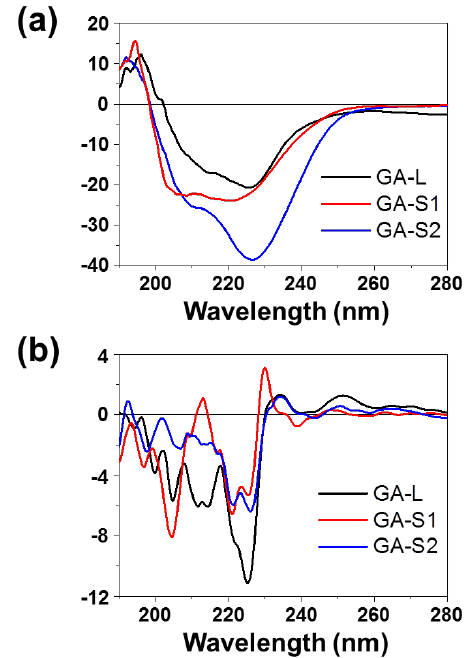
Figure 2. Circular dichroism spectra of GA-S1, GA-S2 and GA-L recorded in ( a ) ethanol and ( b ) chloroform. The peptide concentration was 5 mg/mL in all cases.